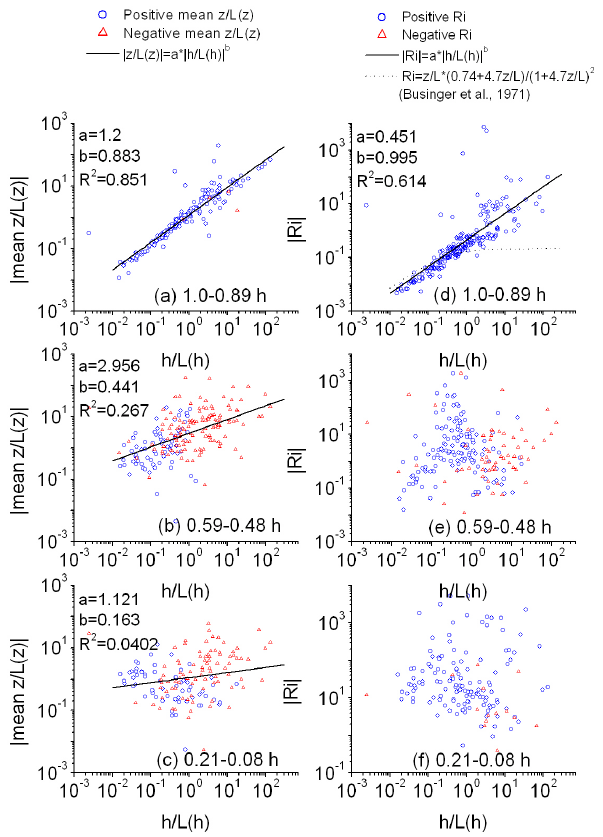
Fig. 3. Comparison of local stability parameters, i.e., mean local z/L(z) and local Richardson number Ri in the top (1.0–0.89h), mid- dle (0.59–0.48h) and low (0.21–0.08h) layers, with the atmospheric stability parameter h/L(h) at tree top. The dotted curve in (d) is the predicted Ri from h/L(h) (replacing z/L ) with the formula given by Businger et al.